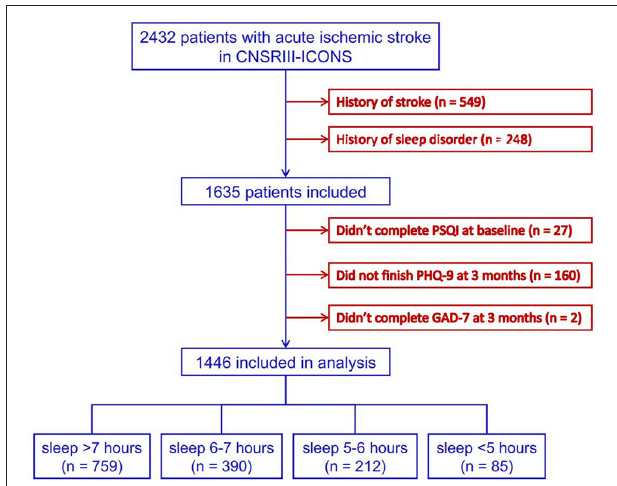
FIGURE 1 | Flowchart of patient enrollment. CNSR-III-ICONS, China National Stroke Registry-III-the impairment of cognition and sleep after acute ischemic stroke or transient ischemic attack in Chinese patient study; PSQI, Pittsburgh Sleep Quality Index; PHQ-9, Patient Health Questionnaire-9; GAD-7, General Anxiety